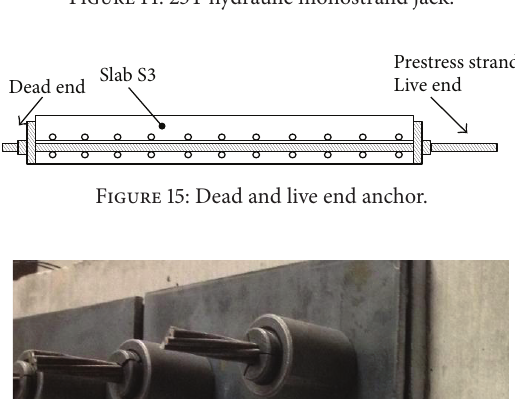
Figure 12: Lifting eye positioned during casting.